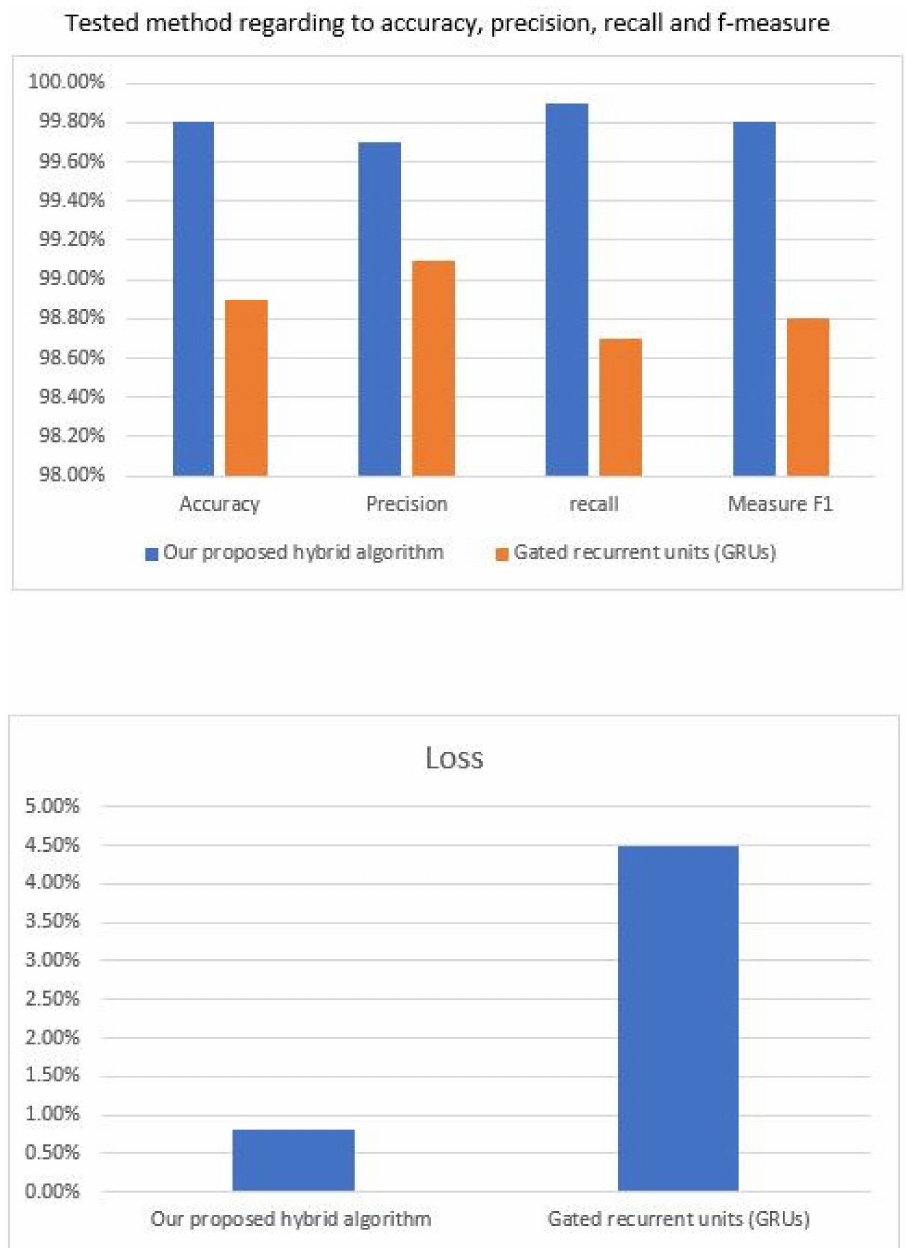
Figure 8. The results of our proposed hybrid method with the GRU method regarding the CICD- DoS2019